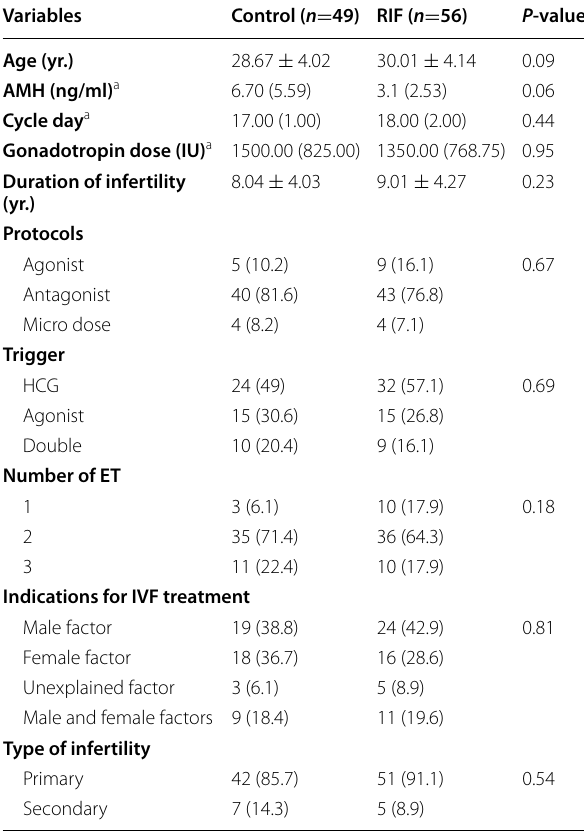
Table 4 Maternal characteristics of the patients in the control and RIF groups of the frozen-thawed ET cycles ( n